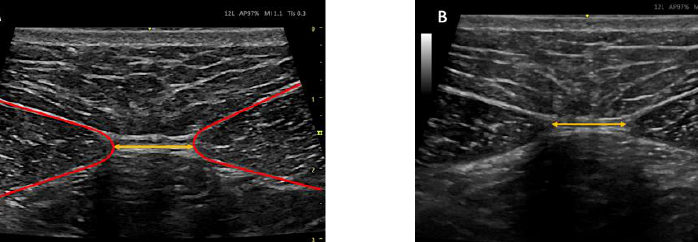
Figure 4. Ultrasound images of the rectus abdominis distance (IRD). ( A ) Right and left abdominal rectus abdominis (areas between the red lines) and intermediate fascia corresponding to the IRD (represented by the yellow line). ( B ) Ultrasound image of the IRD at rest. ( C ) Ultrasound image of the IRD during muscle activity.